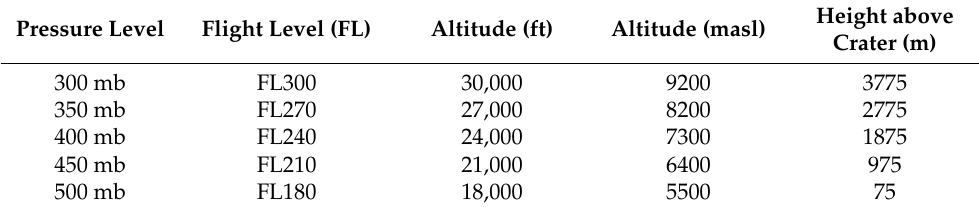
Table 2. Flight levels in the airspace and its corresponding pressure